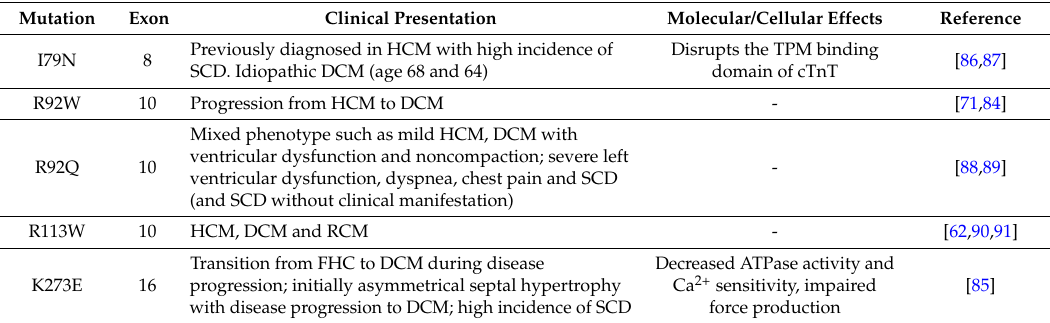
Table 2. Mutations in TNNT2 associated with multiple cardiomyopathies, including hypertrophic cardiomyopathy (HCM), dilated cardiomyopathy (DCM), restrictive cardiomyopathy (RCM), sudden cardiac death